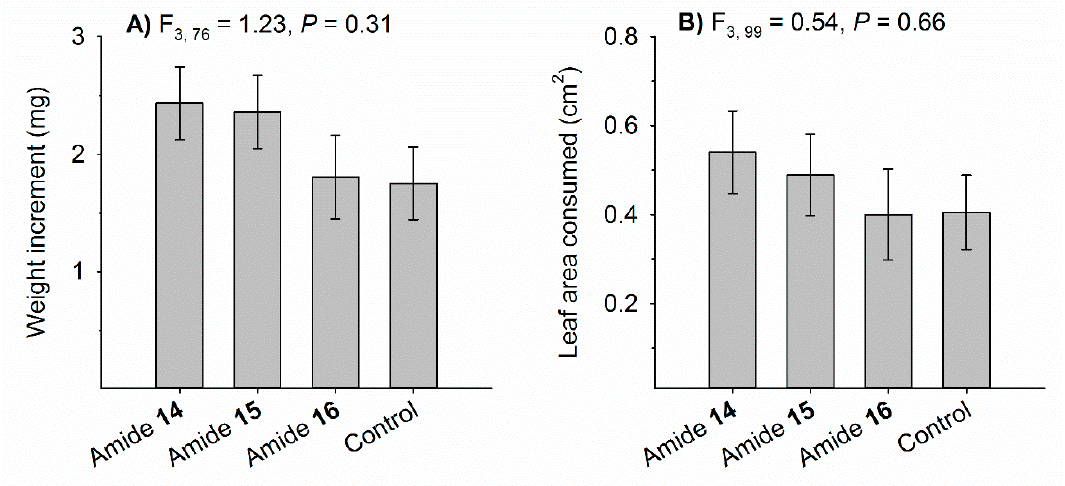
Figure 3. Weight increment ( A ) and leaf area consumed ( B ) by Tuta absoluta larvae topically treated with the LD 25 of amides 14 , 15, and 16 . Control = acetone.